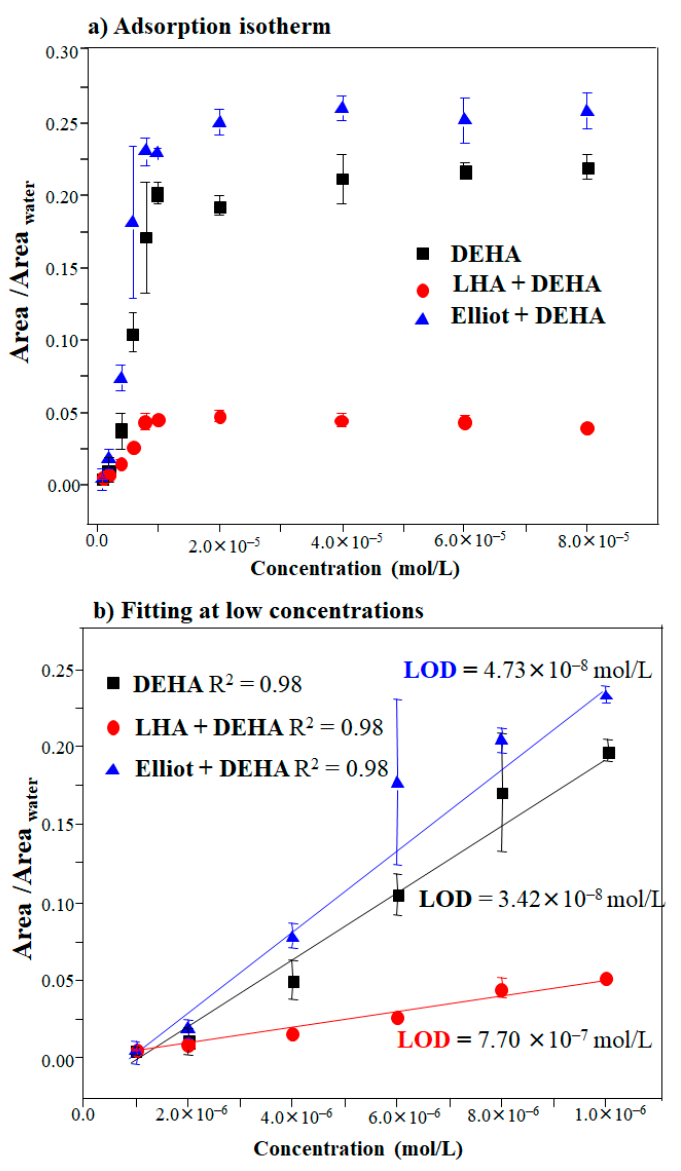
Figure 5. ( a ) Langmuir-type adsorption isotherm of DEHA in the absence and presence of LHA and EHA onto AgNPs (colloid) and ( b ) its linear fitting at low concentrations.